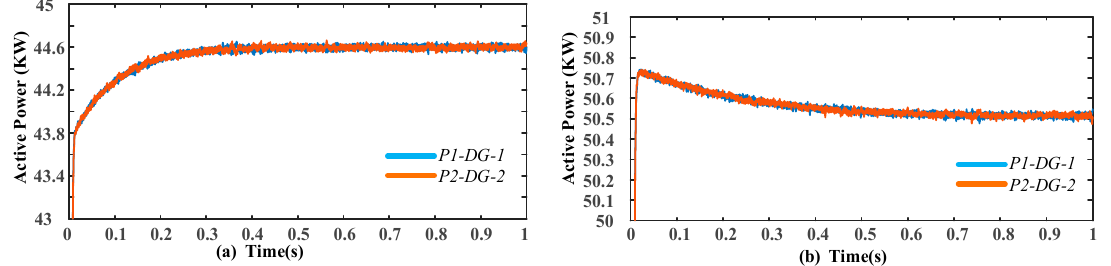
Figure 12. ( a ) Inverter terminal and load voltages for the conventional control strategy; ( b ) inverter terminal and load voltages for the proposed control strategy.